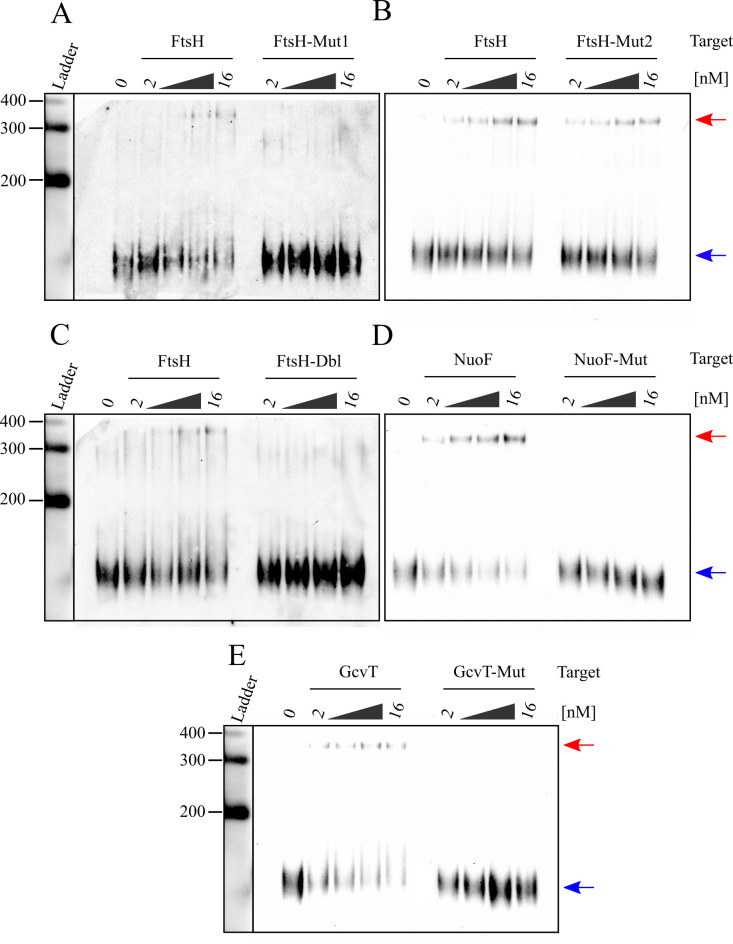
BbsR9 binds to ftsH, nuoF, and gcvT transcripts via specific GC-rich seed regions.RNA-RNA EMSAs showing dose-dependency of biotin-labeled BbsR9 binding to wild-type but not mutated, in vitro-transcribed segments of A-C)
ftsH, D)
nuoF and E)
gcvT. Mutated regions correspond to those shown in Fig 6B, and “Dbl” specifies the double ftsH mutant. Red and blue arrows indicate bands corresponding to BbsR9 bound and unbound to target RNAs, respectively. All lanes contained 2 nM biotin-labeled BbsR9 in addition to increasing amounts of the indicated target (2 nM, 4 nM, 8 nM, and 16 nM).